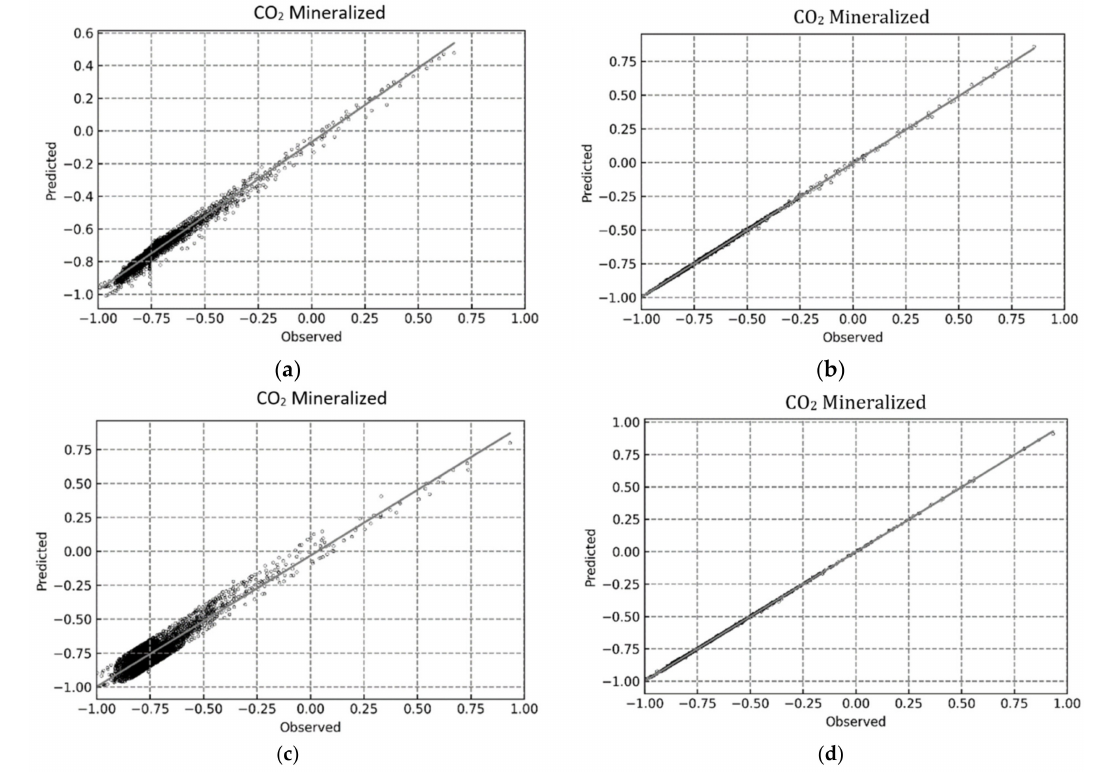
Figure 14. Regression plots for determining CO 2 mineralized using the proposed ML-based models.